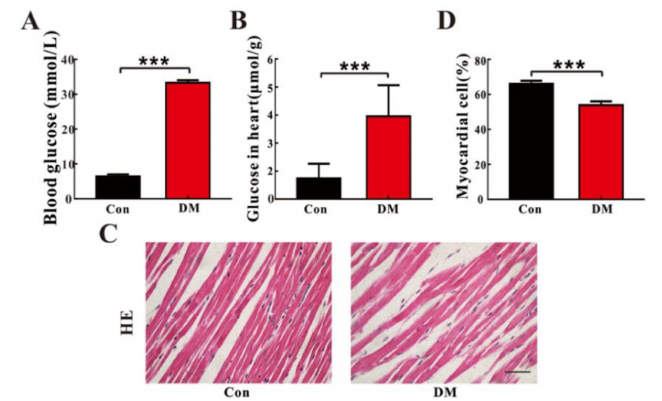
Figure 1. Changes in H9c2 cell number under normal glucose (NG, 5.5 mM) and high glucose (HG, 33 mM) conditions: ( A ) representative graphs of Hoechst 33342 staining of cell apoptosis after NG or HG exposure for 48 h; ( B ) the percentage of H9c2 cell apoptosis based on Hoechst 33342 staining (Means ± SE, n = 3); ( C ) representative graphs of flow cytometry analysis of cell apoptosis after NG or HG exposure for 48 h; in these four quadrants, viable cells are located in the left lower quadrant (FITC − /PI − ), early apoptotic cells in the right lower quadrant (FITC+/PI − ), late apoptotic cells in the right upper quadrant (FITC+/PI+), and necrotic cells in the left upper quadrant (FITC − /PI+); ( D ) the percentage of H9c2 cell apoptosis based on flow cytometry analysis (Means ± SE, n = 3); significant level: *** p < 0.001.